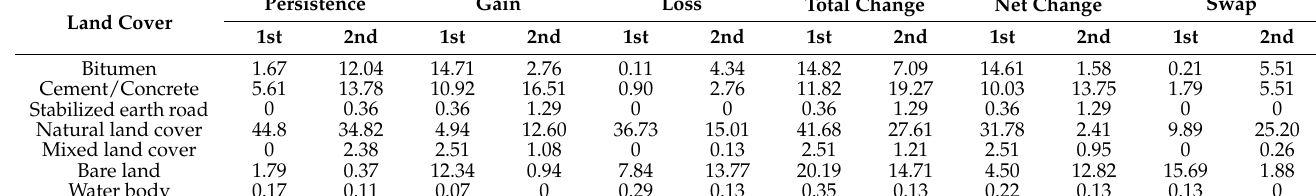
Table 3. Land-cover changes in terms of percent of the campus surface where 1st is 1997–2007; 2nd is 2007–2017. Land Cover